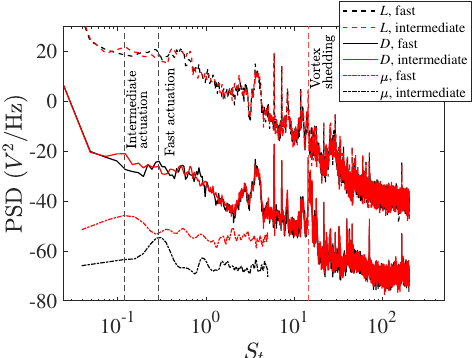
Figure 8. Power spectra density of Lift L (dotted), drag D (solid) and membrane deformation ( µ ) curves at two actuation frequencies, fast (black), and intermediate (red). Frequency peaks are identified at St = 0.3 at fast actuation, whilst St = 0.12 at intermediate